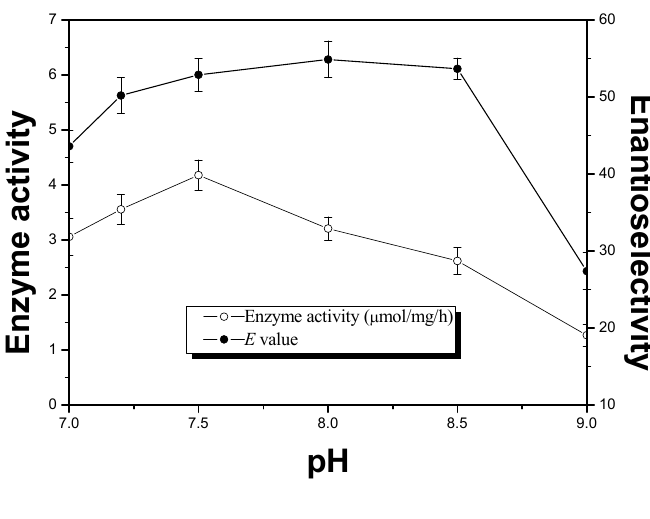
Figure 3. Effects of pH on enzyme activity ( μ mol/mg/h, ○ ) and enantioselectivity ( E value, ● ) in the enzyme-catalyzed esterification of ibuprofen. The reactions were carried out in n -heptane (60 mL), ibuprofen (0.02 M), 1-octanol (0.02 M), APE 1547 (60 mg) with different pH. The mixture was incubated in the microwave oven (480W, 50 °C, 150